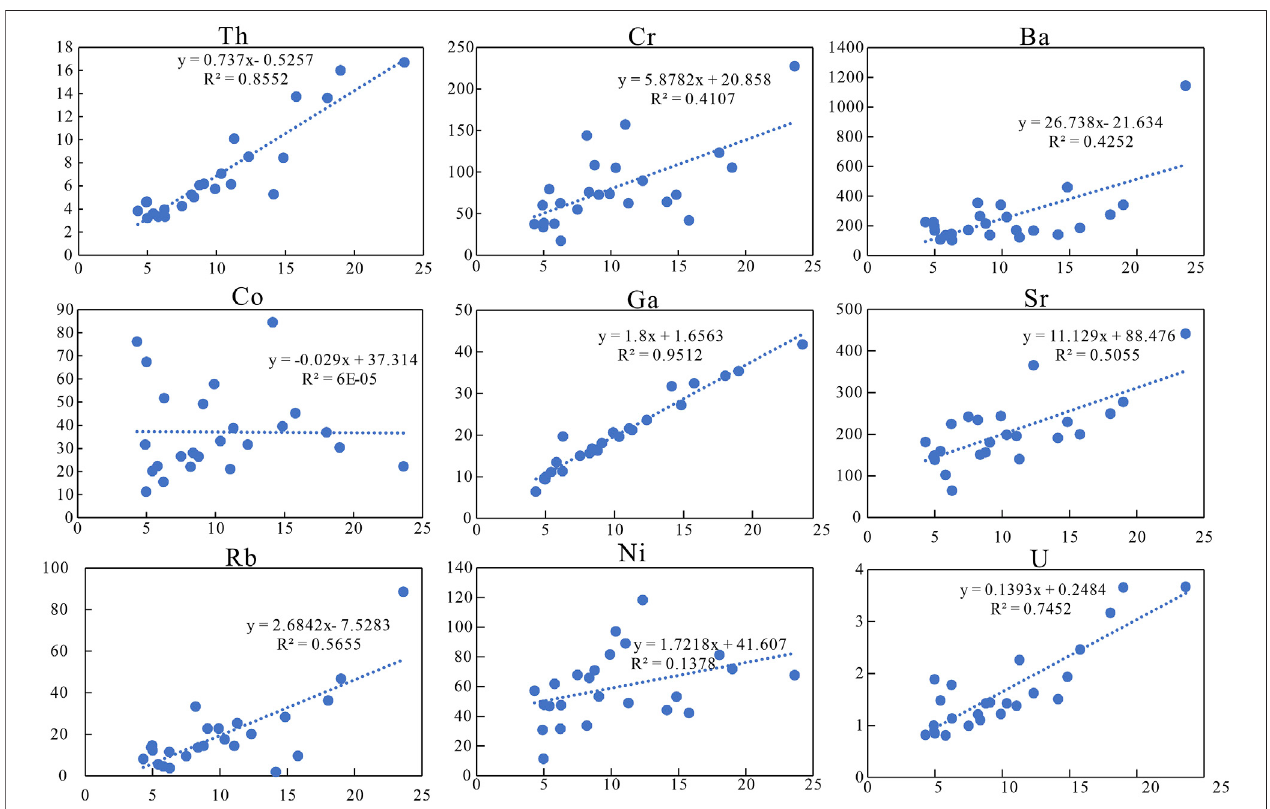
FIGURE 4 | Covariant relationship between Al and some trace elements, in which Th, Ga, and U are positively correlated with Al.